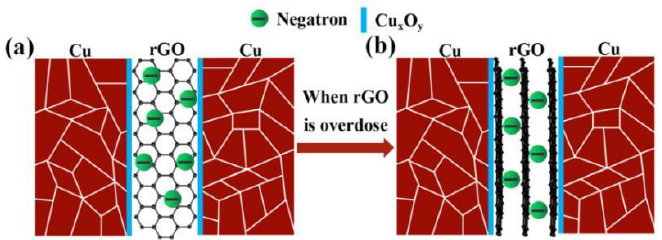
Figure 12. ( a ) When effectively coated, the rGO on the Cu surface provides a fast path for electron motion. ( b ) When rGO is overdosed, there is a phenomenon of multi-layer coating, which limits the movement of electrons.